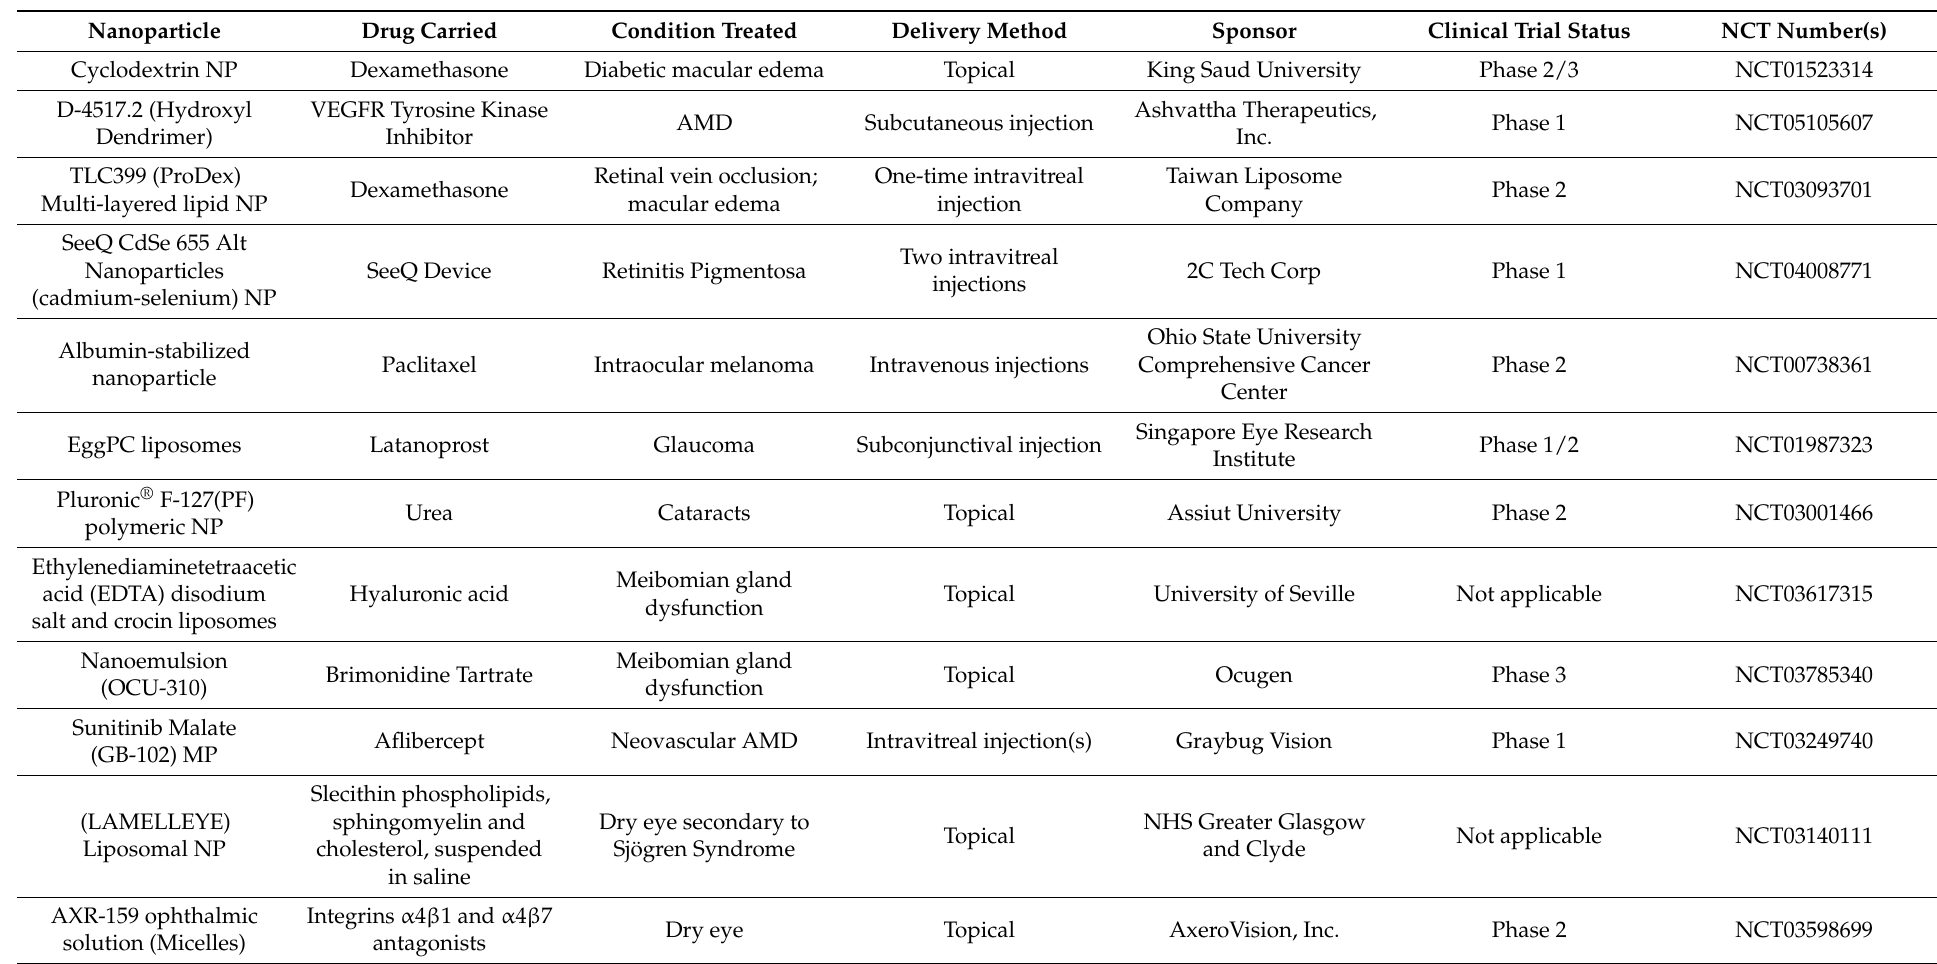
Table 4. Current and past clinical trials using emerging drug delivery